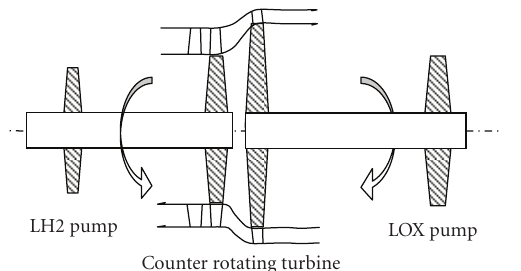
Figure 1: Counter-rotating turbopump.